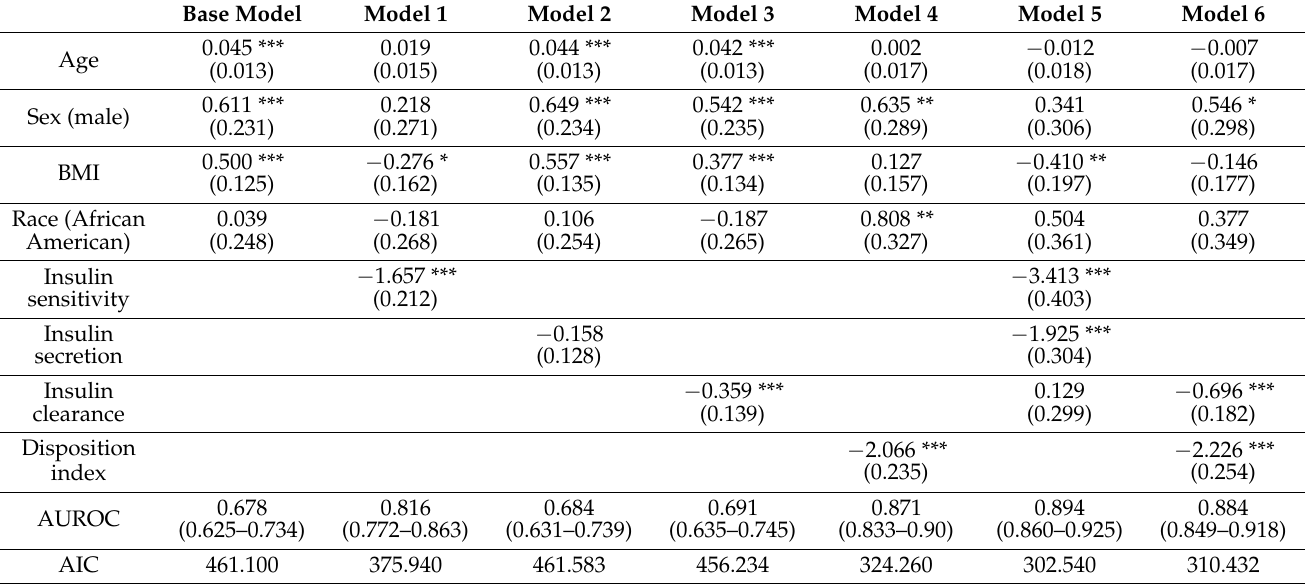
Table 3. Parameter estimates and area under the receiver operating characteristics curve for logistic regression mod- els examining the association of four insulin homeostasis traits with dysglycemia, in separate models and for models combining traits.